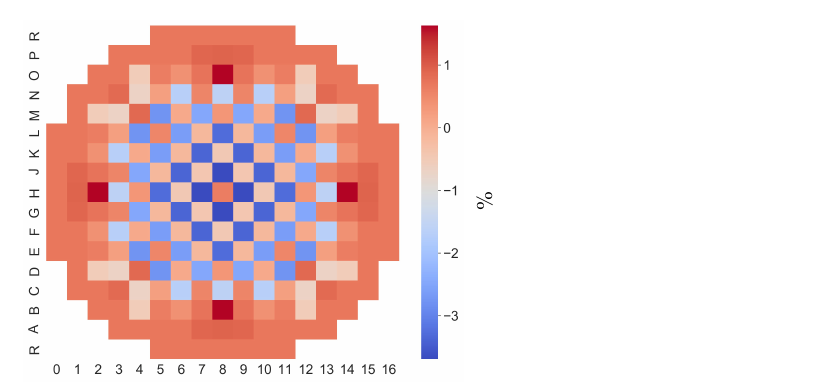
and the benchmark